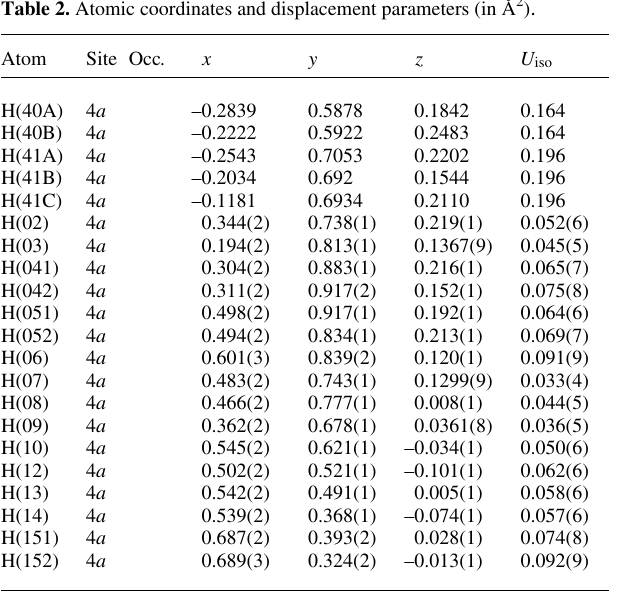
Table 2. Atomic coordinates and displacement parameters (in Å 2 ) .